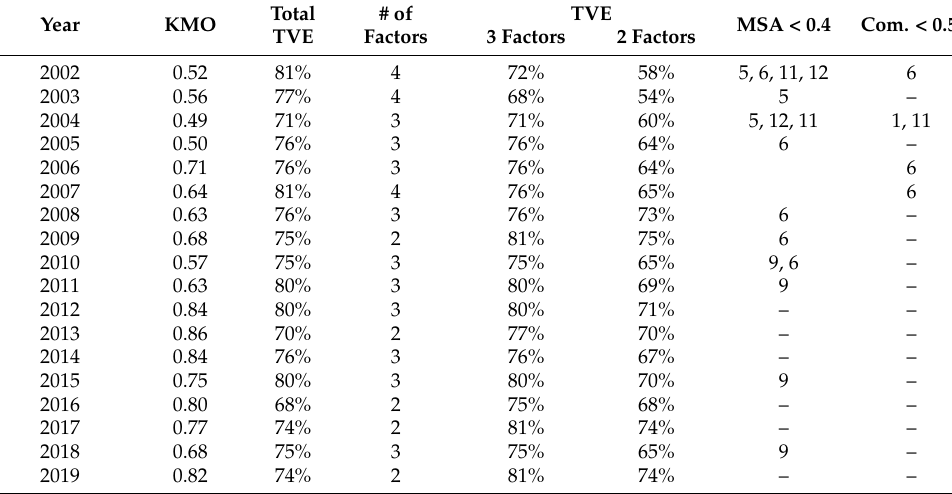
Table 4. Factor analysis for each year from 2002 to 2019.